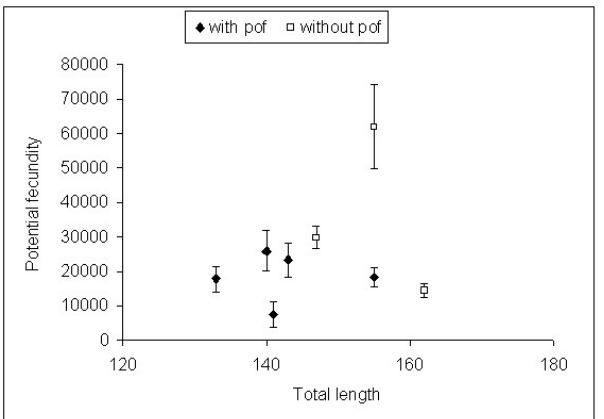
Fig. 11 . Temporal variation of the mean values of the gonadosomatic relationship (GSR) of the Bay whiff in the Mamanguá Inlet. Bars= standard